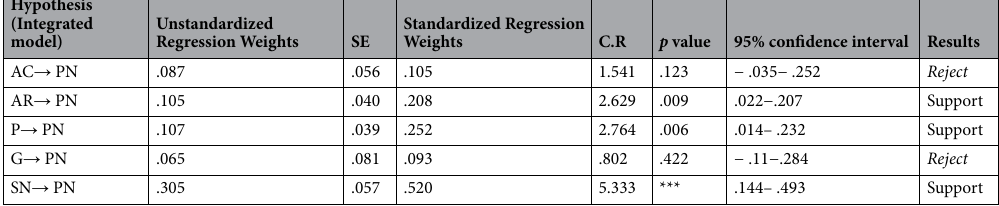
Figure 4. Integrated model.